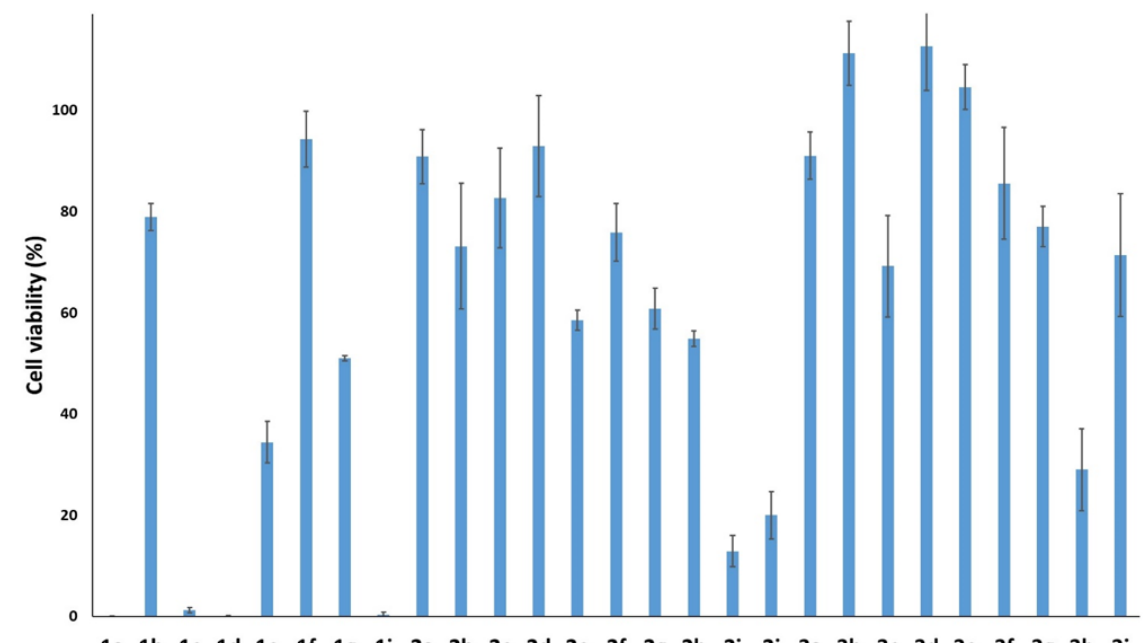
Figure 2. The cytotoxicity effect of tested compounds 1a – g , 1i , 2a – 2j , 3a – 3h, 3j at 100 μM on cancer HCT116 cells based on MTT assay after 48h of treatment.